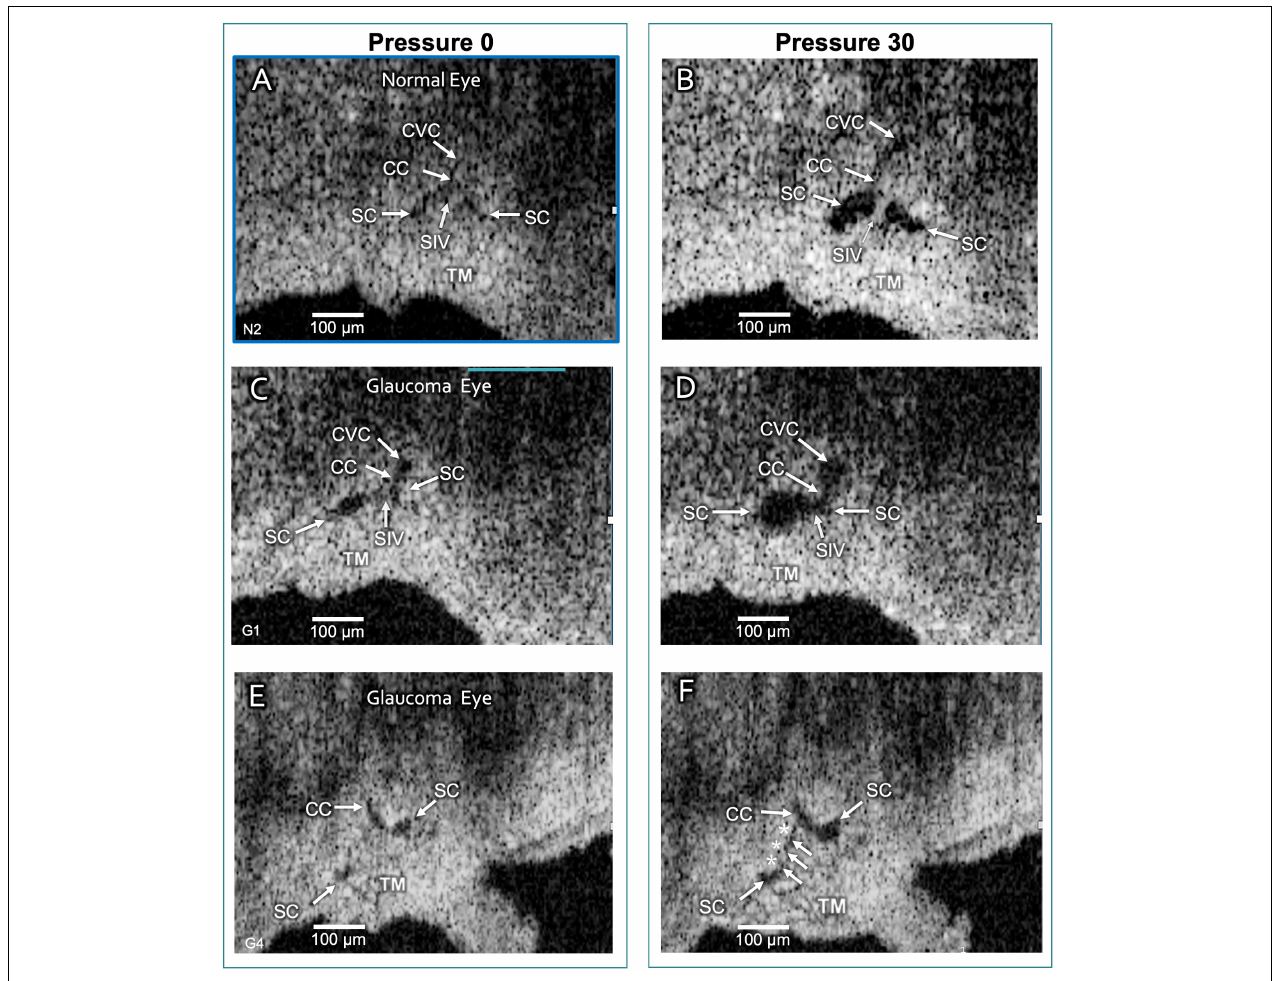
FIGURE 6 | Schlemm’s canal and collector channel configuration changes. The 2D high-resolution cross-section (i.e., B-scan) OCT images in (A,C,E) are at 0 mm Hg hydrostatic reservoir pressure, while images in (B,D,F) are at 30 mm Hg. Schlemm’s canal (SC) spans between the paired arrows. In (B,D) , the lumen of SC, collector channel (CC) entrances, and the circumferentially-oriented vessel compartments (CVC) become markedly enlarged. Schlemm’s canal inlet valve-like structure (SIV) attachments between the trabecular meshwork (TM) and SC external wall elongation. (E,F) are from a glaucomatous eye. In (F) , the TM remains in the CC entrance. TM motion is marked, but adhesions between the TM (white arrows) and SC external wall (asterisks) prevent SC from